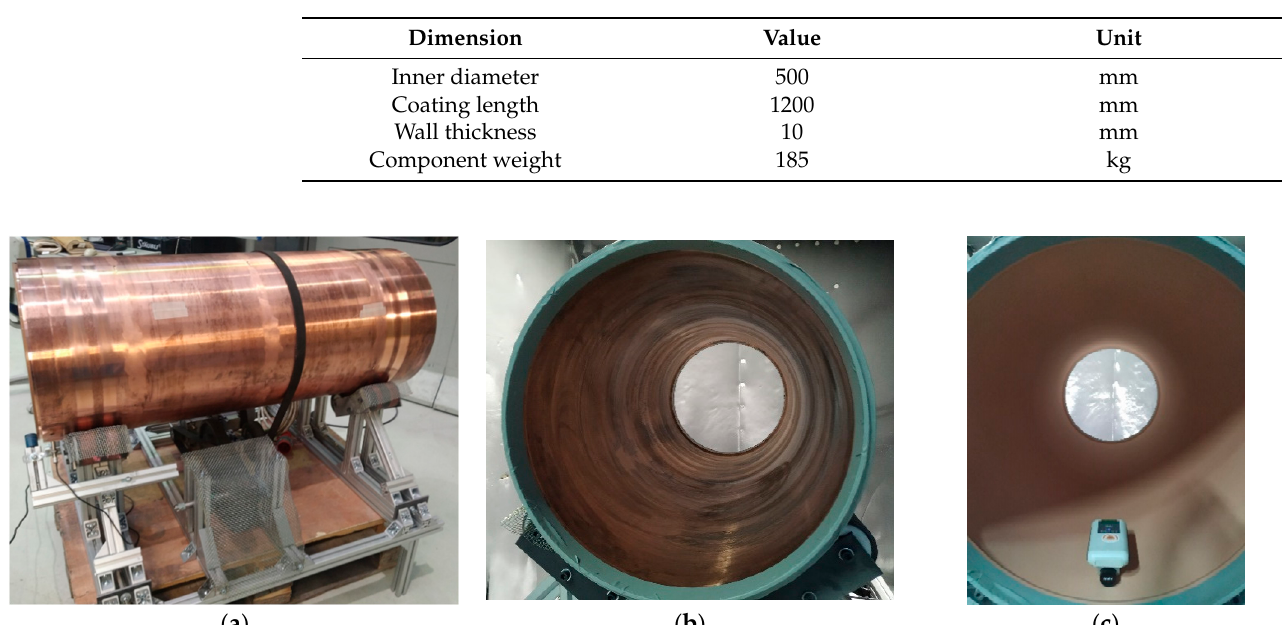
Table 1. Approximate tube dimensions.